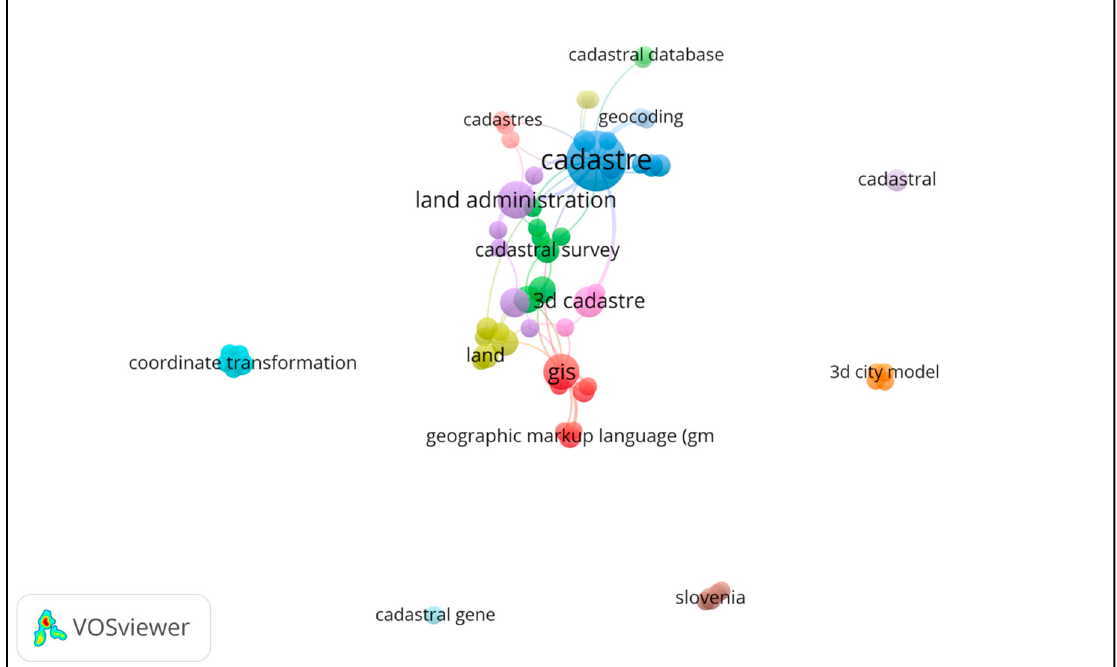
Figure 4. Keyword network map 2002–2007.